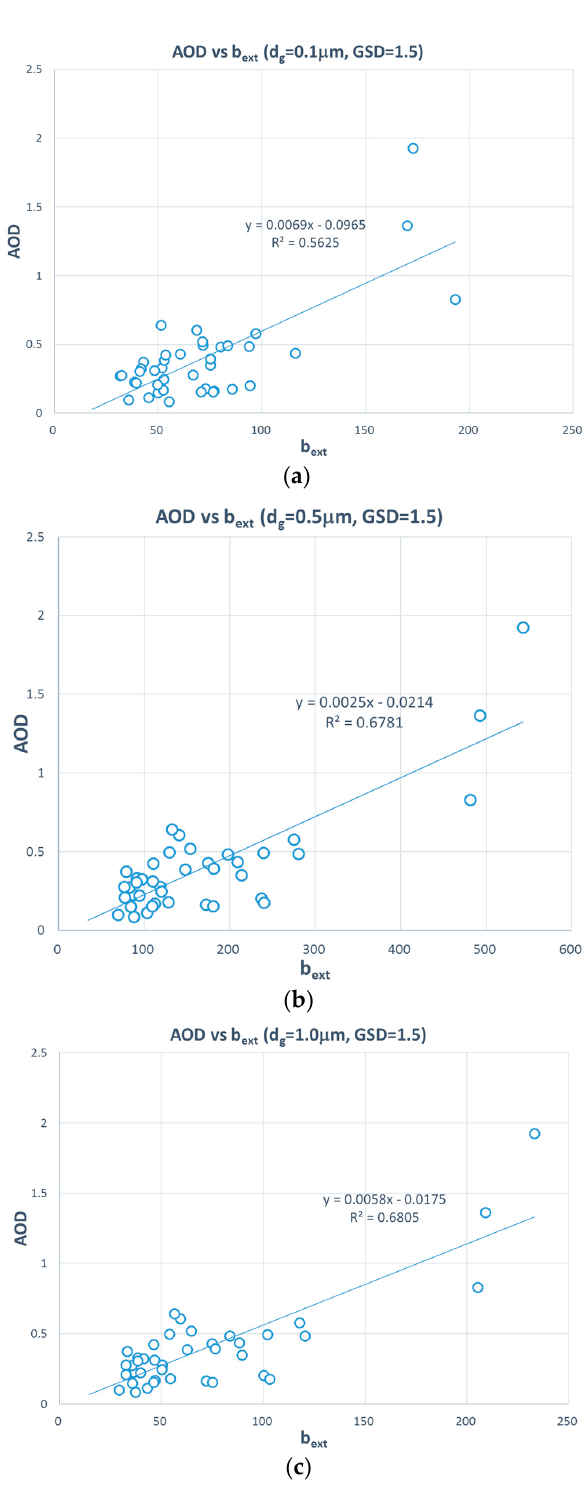
Figure 8. Comparisons of our determined b ext with AOD (Aerosol Optical Depth) from Aerosol Robotic Network (AERONET) (Seoul-SNU station, 37.458 N, 126.951 E) during the sampling period for a GSD = 1.5 and for ( a ) dg = 0.1 µm, ( b ) dg = 0.5 µm, and ( c ) dg = 1.0 µm.